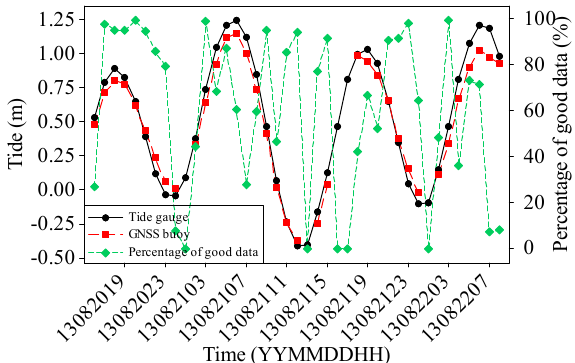
Figure 6. Comparison of tide data obtained from the GNSS buoy and tide gauge (20–22 August 2013).